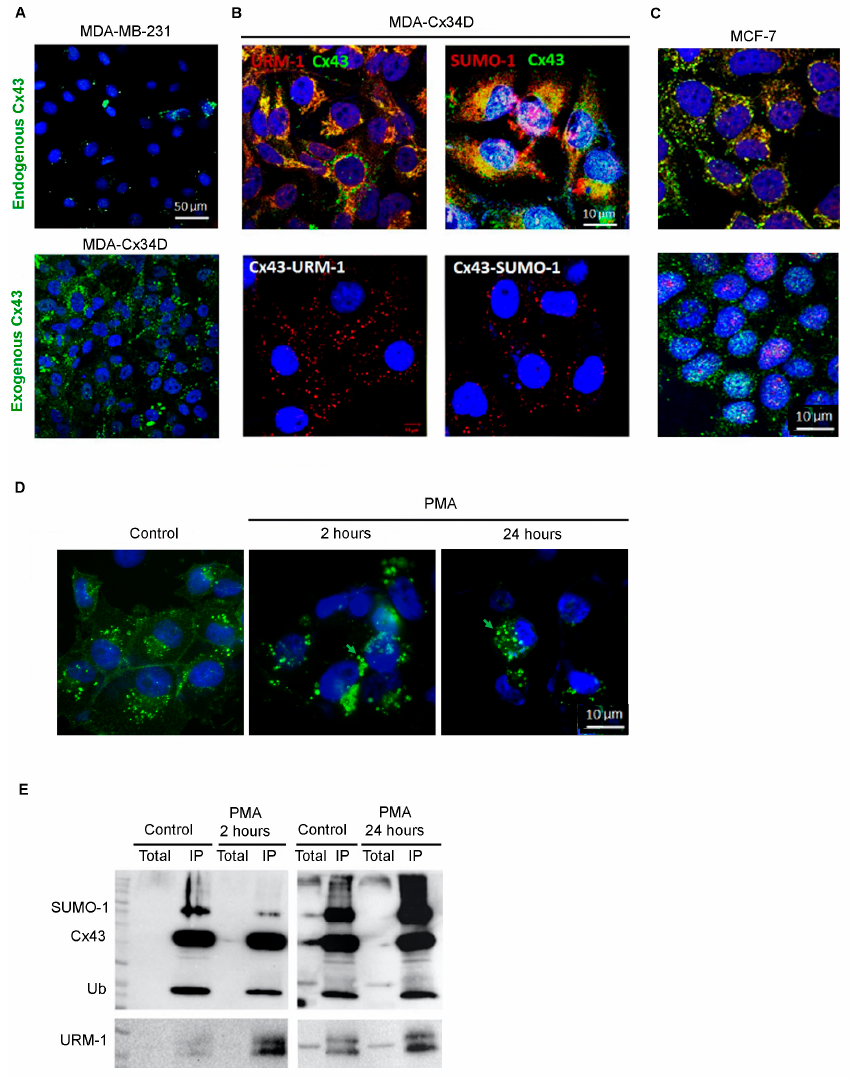
Figure 1. Cx43 interacts with URM-1 and SUMO-1 in breast cancer cells. ( A ) MDA-MB-231 cells express low levels of endogenous Cx43, which was upregulated in MDA-Cx34D cells. ( B ) Immunofluorescence assay (upper panel) and Duolink ® in situ proximity ligation assay (lower panel) were performed in MDA-Cx43D cells. Cx43 co-localizes and interacts with URM-1 and SUMO-1 primarily in the cytoplasmic compartment. ( C ) Immunofluorescence assay shows co-localization of Cx43 with URM-1 and SUMO-1 in MCF-7 cells. ( D ) Immunofluorescence assay shows annular junction formation (green arrows) in MDA-Cx43D upon treatment for 2 h and 24 h post-treatment with PMA. ( E ) MDA-Cx43D cells were treated with PMA, and Cx43 was evaluated by fluorescence. Micrographs show that PMA resulted in the internalization of Cx43. ( E ) Immunoprecipitation assay showed that URM-1 co-precipitates with Cx43 as early as 2 h post-PMA treatment, and that SUMO-1 heavily interacts with Cx43 24 h post-PMA treatment. All panels are representative of at least three experiments. DAPI is shown in blue, SUMO-1 and URM-1 are shown in red, and Cx43 is shown in green.